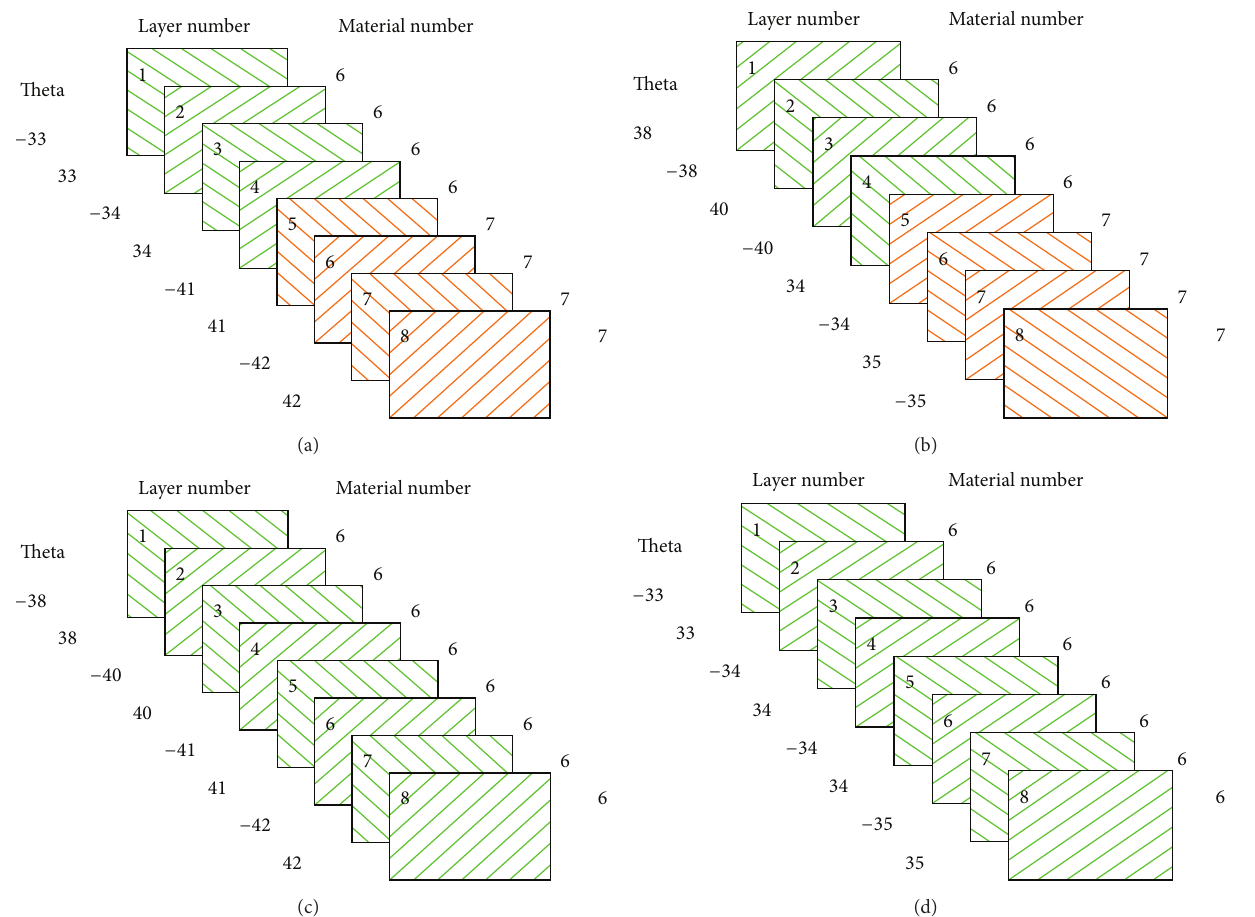
Figure 7: Lay-up sequences and ply angles of composite shafts. (a) [C] 2 [G] 2 , (b) [G] 2 [C] 2 , (c) [G] 4 , and (d) [C] 4 .